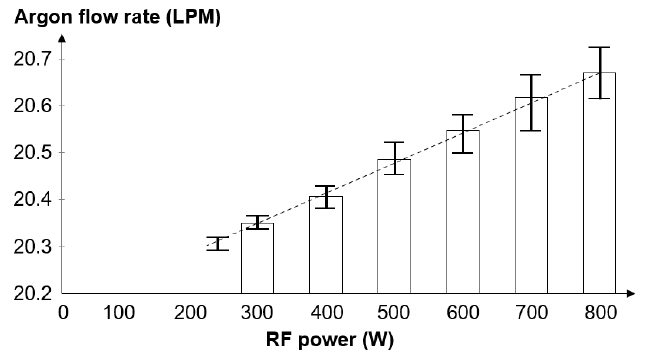
Figure 7. Argon flow rate versus RF power for the main gas flow.